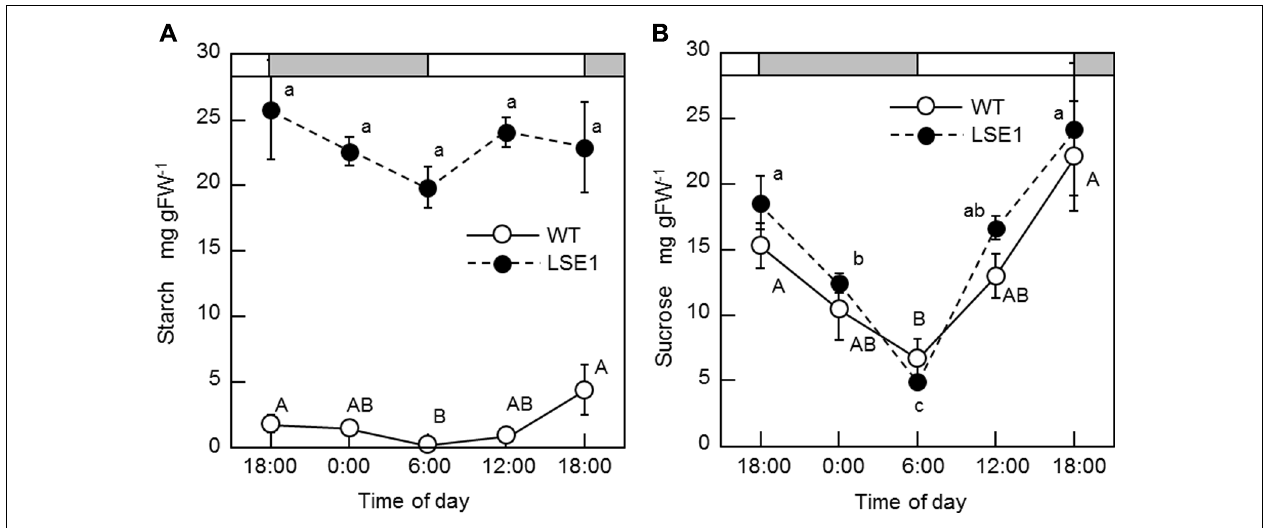
were harvested at designated times of the day and used for the measurements. Data represent the mean ± SE ( n = 5) and the different letters indicate significant differences within each of the two lines, capital letters forWT and small letters for LSE1 ( p < 0.05, Tukey’s